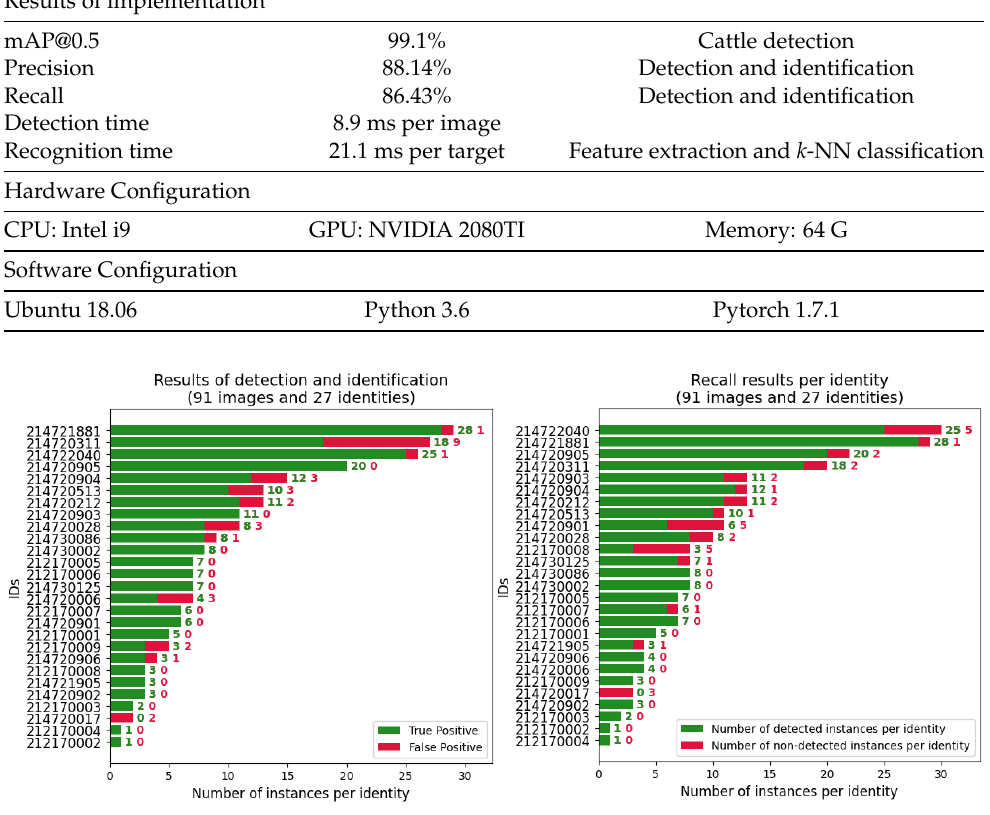
Figure 9. Precision and recall results. ( Left ) The precision of the detection and identification per identity with the mean precision achieving 88.14%. ( Right ) The recall of detection and identification per identity with a mean value of 86.43%. Best viewed in